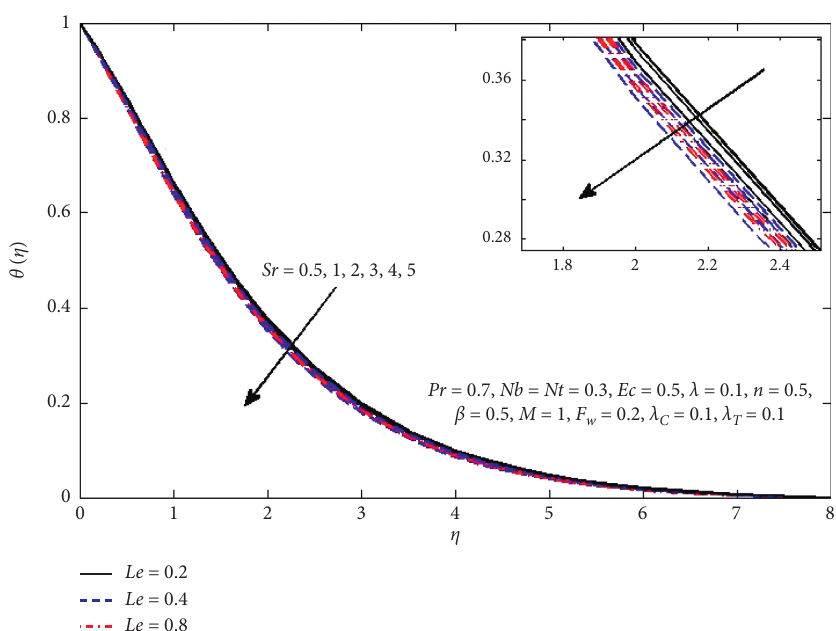
Figure 21: Variation of temperature θ concerning η with various values of Sr and Le.